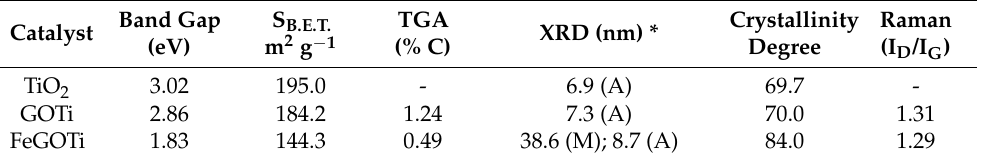
Table 1. Main characterization results concerning the photocatalyst studied: reference TiO 2 , 1%